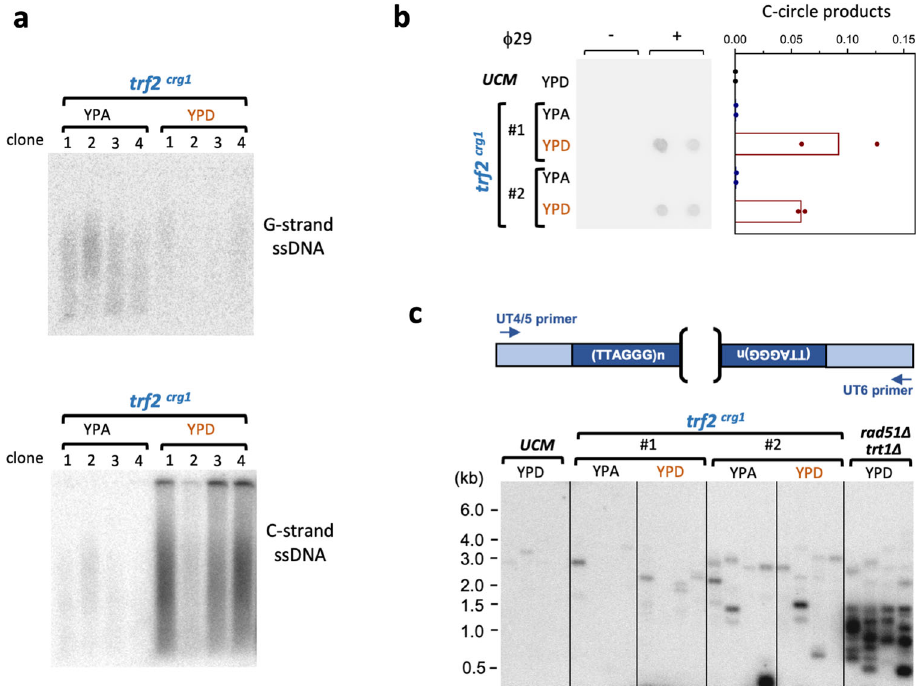
Fig. 6 Ustilago maydis Trf2 suppresses multiple telomere aberrations. a DNAs from multiple, independently constructed trf2 crg1 strains grown in YPA or YPD were assayed for the levels of unpaired G-strand and C-strand telomere DNA by in-gel hybridization. b The indicated chromosomal DNA preparations were subjected to duplicate C-circle assays. The scan of the blot is shown on the left and the quanti fi cation (means; n = 2 experimental replicates; normalized against the average value of ku70 nar1 samples in Fig. 4e) plotted on the right. Note that these assays were performed concurrently with those in Fig. 4e and quanti fi ed from the same blot. c The DNAs from the indicated strains grown in the given media were subjected to telomere fusion